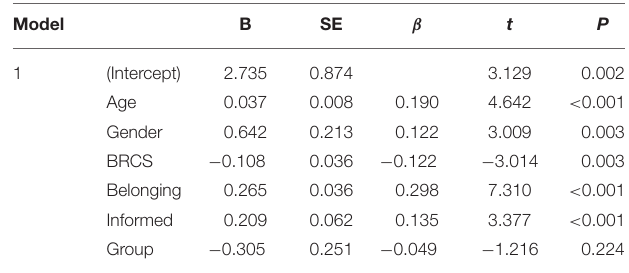
TABLE 4 | Linear regression analysis on the prediction of Fear in the whole dataset, which reached statistical significance: F (6, 518) = 19.86; MSE = 103.56; R 2 = 0.19; p <